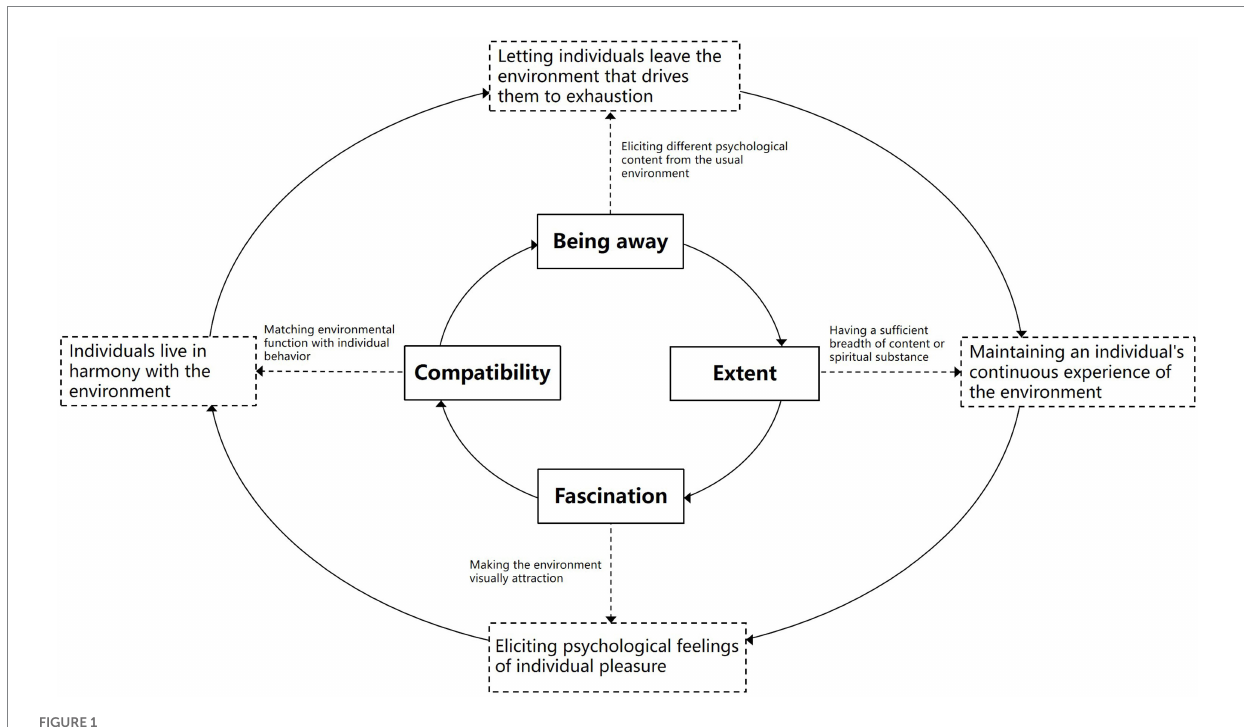
FIGURE 1 Four characteristics of restorative environment (15,